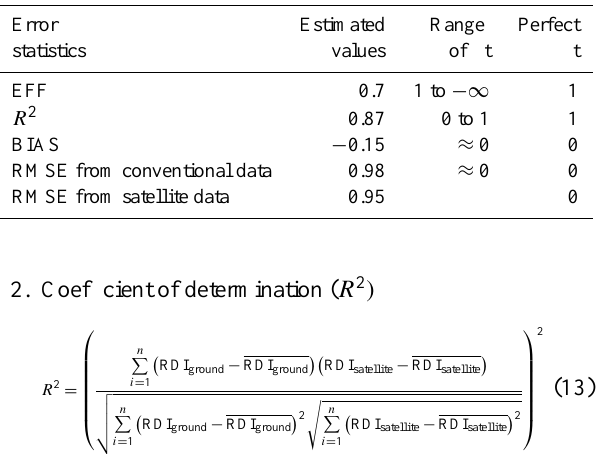
Table 3. The results of error statistics (monthly RDI).